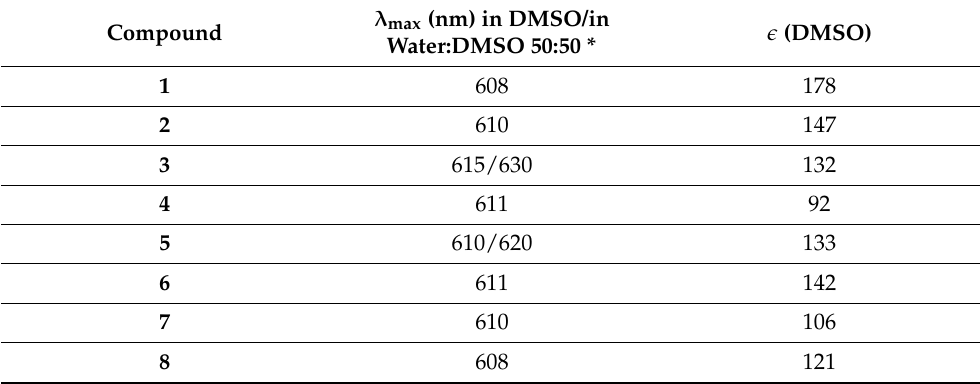
Table 3. Wavelength of the maximum absorption ( λ max , nm) and molar absorptivity ( (cid:101) ).